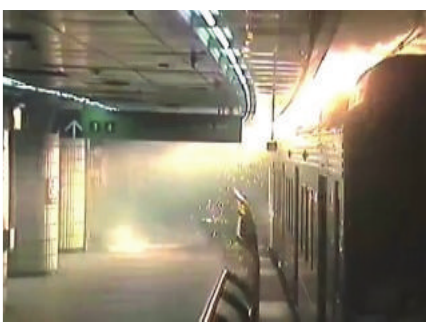
Figure 8: Sample images of CCTV